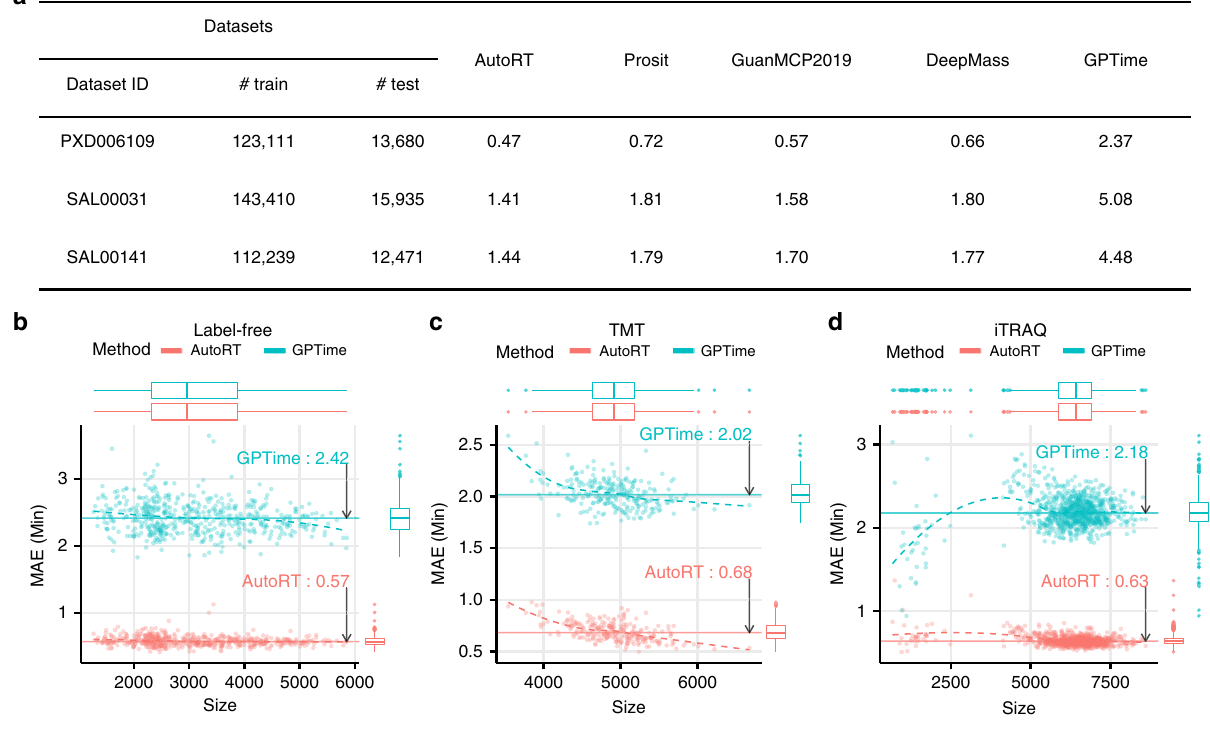
Fig. 2 Peptide retention time prediction performance evaluation. a Benchmarking AutoRT against three deep learning-based retention time (RT) prediction tools (Prosit, GuanMCP2019, and DeepMass) and one traditional machine learning-based tool GPTime based on median absolute errors (MAEs) of the predicted peptide RTs in three data sets. b – d MAE distribution for the CPTAC label-free b , TMT c , and iTRAQ d data sets, respectively. Each data point in the scatter plots represents a single LC-MS/MS run, and the numbers are the median MAEs (minute) across all runs in a data set. The boxplots on the top show the size distribution of training data, whereas the boxplots on the right show the MAE distribution. Dashed lines are fi tted lines using LOESS model. Source data are provided as a Source Data fi le. For boxplots, centerline indicates the median, box limits indicate upper and lower quartiles, whiskers indicate the 1.5 interquartile range and points indicate